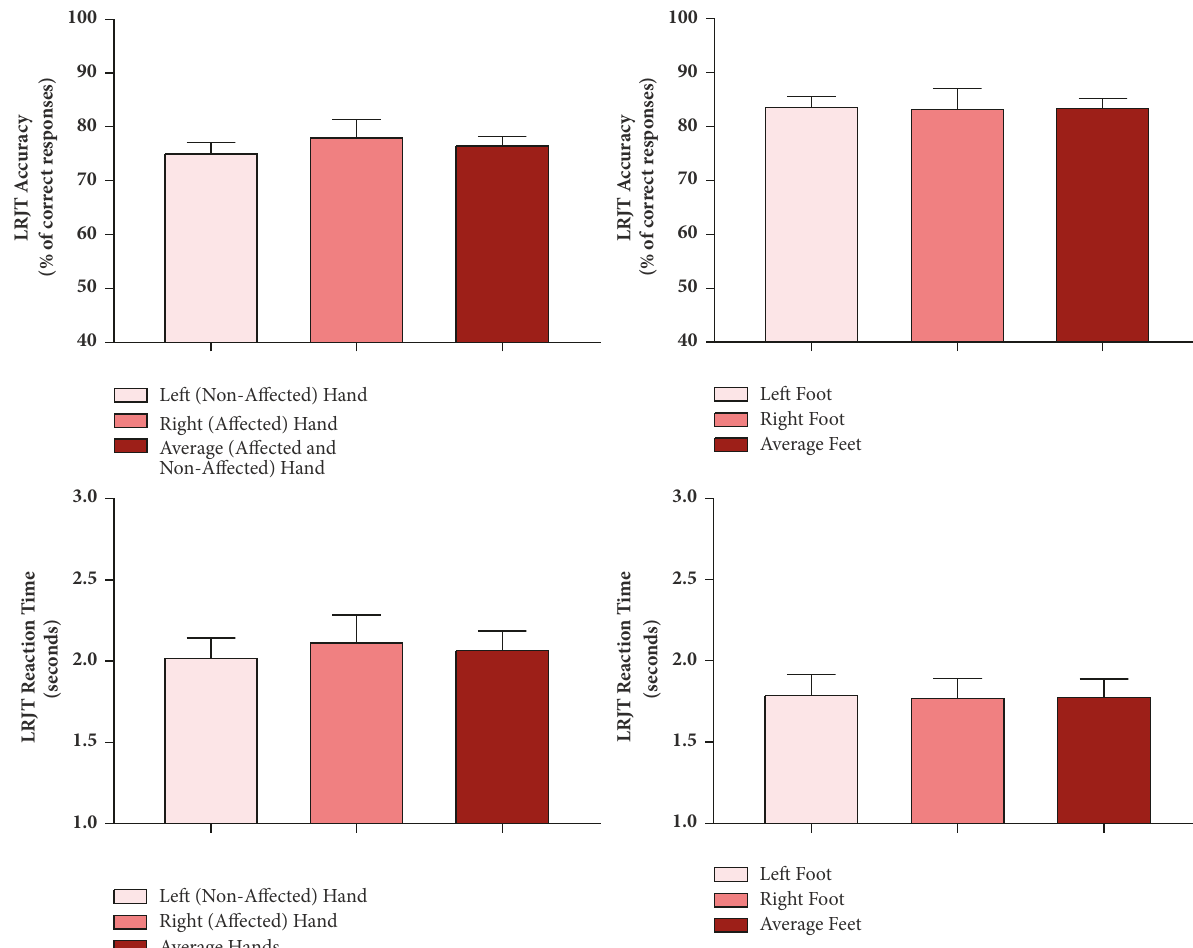
Figure 1: Left Right Judgement Task (LRJT) performance in participants with musculoskeletal disorders of the wrist/hand. Mean ± 95% Confidence